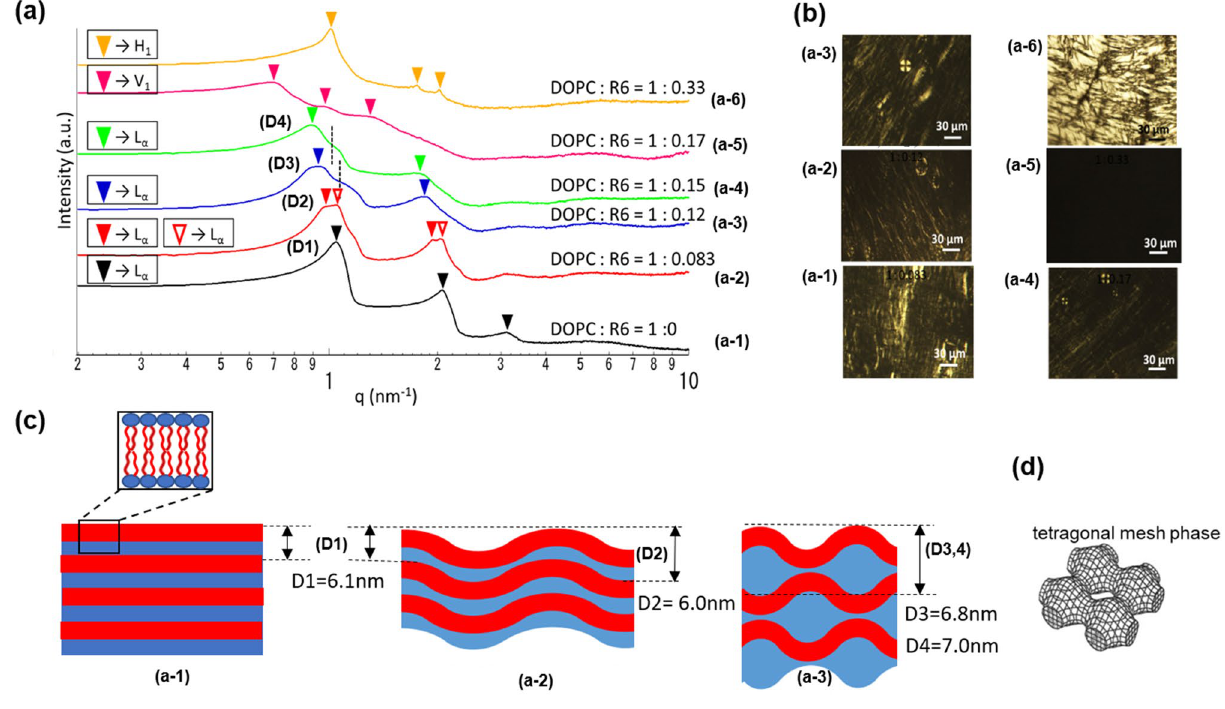
Figure 2. Effect of R6 to the structure of lyotropic liquid crystal composed of DOPC/Water (60/40 wt %) system at 25 °C. ( a ) Small angle Xray scattering (SAXS) spectra for DOPC/Water (60/40 wt %) system with addition of R6; ( a-1 ) , ( a-2 ) , ( a-3 ) , ( a-4 ) are Lα with q value peak ratio 1:2:3, Coexistence of V 1 phase with the shoulder peaks were indicated by dotted vertical line for ( a-3 ) and ( a-4 ), ( a-5 ) is V 1 (1:√6:√8 ), and ( a-6 ) is H 1 (1:√3:2); ( b ) Polarized microscope image for each composition, ( c ) Schematic diagram of DOPC/Water Lα based on the results shown in ( a , b ). Expansion of inter layer thickness (D1) to (D2,3,4) indicates curved deformation of planar Lα structure to undulated lamellar as depicted, and D3 and D4 reasonably fit to the Mesh 1 structure as tetragonal mesh 1 shown in ( d